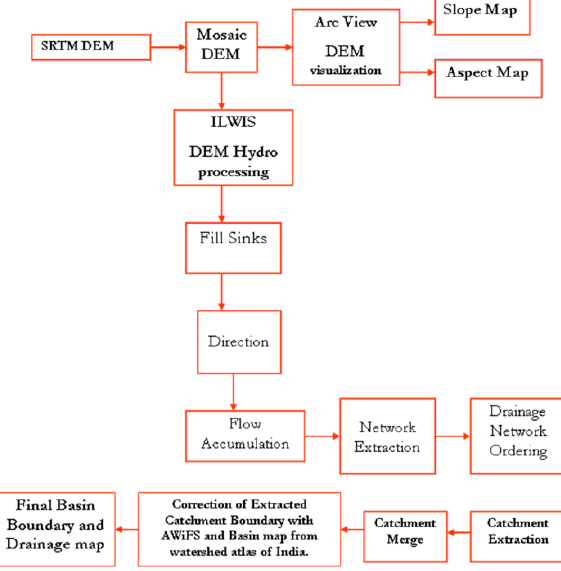
Fig. 2.1. Flowchart for basin hydro-processing The HD simulation were done from Dheng to Benibad stretch of Bagmati River (shown in 1.2). The input river data for both, HEC-RAS and Mike-11 was created from LISS-III image, flood plain elevation was taken from SRTM DEM and river cross sections were taken from